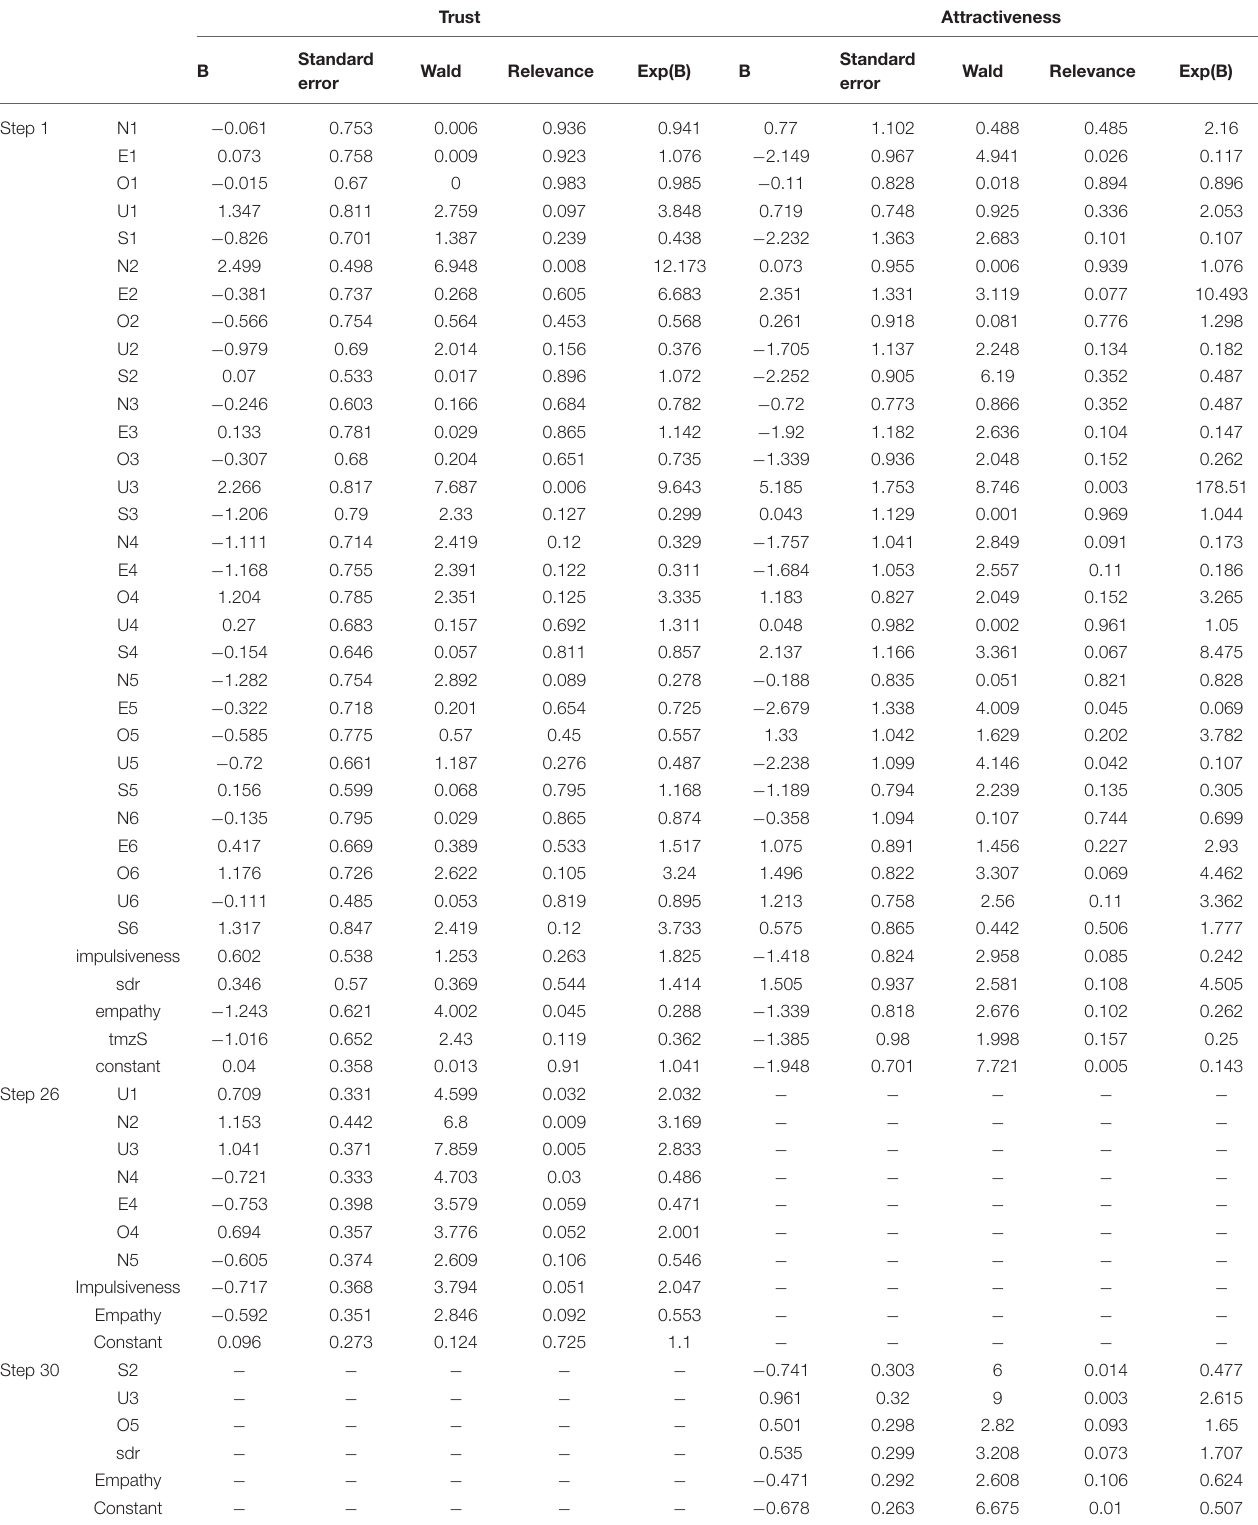
TABLE 10 | Estimating the values of the parameters of the logistic regression model for the dependent variable—attractiveness and trust. Trust